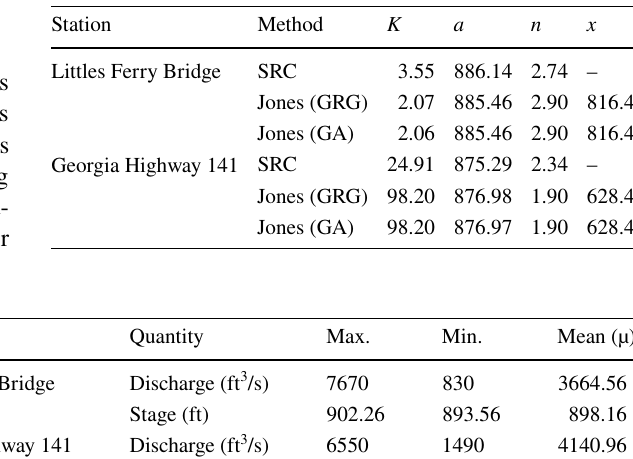
Table 2 Hysteresis rating curve parameters for two sites by